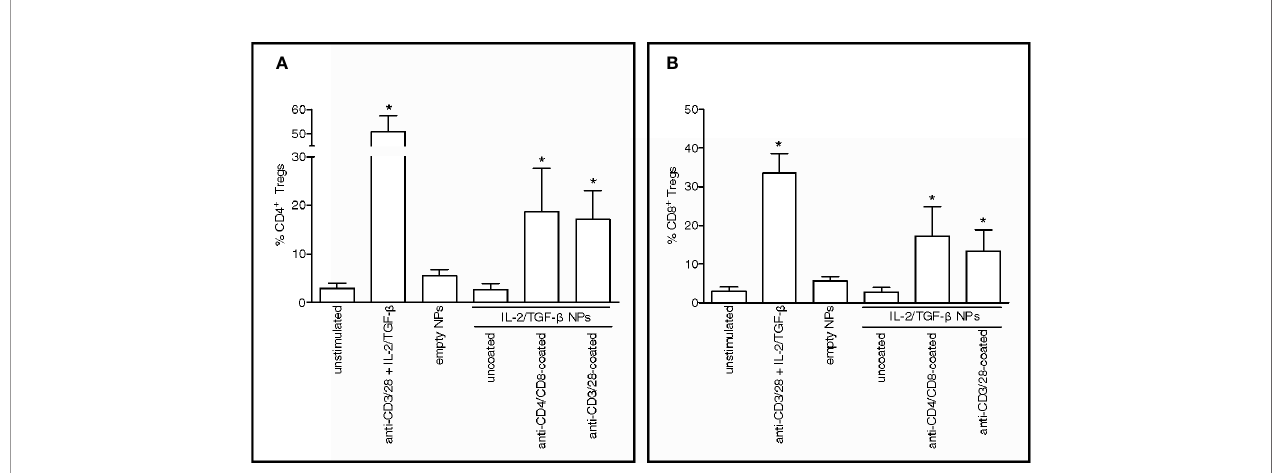
FIGURE 1 | Nanoparticles (NPs) loaded with tolerogenic cytokines and targeted to human T cells induce CD4 + and CD8 + Tregs in vitro . PBMCs from healthy volunteers (n = 5) were cultured for 5 days in the presence of 100 µg/ml NPs loaded with IL-2 and TGF- b that had been either left uncoated or decorated with antibodies to T cells (anti-CD4/CD8 or anti-CD3/28). Cultures with medium only and either no NPs (unstimulated) or NPs kept unloaded (empty) served as negative controls; cultures with anti-CD3/28 beads at a ratio of 0.2 beads/cell in the presence of soluble IL-2 and TGF- b served as positive control. Results show increased numbers of CD4 + CD25 hi CD127 - FoxP3 + (A) and CD8 + FoxP3 + T cells (B) in the presence of NPs decorated with anti-CD4/CD8 Ab or anti-CD3/CD28 Ab. *P < 0.05 by the Student ’ s t test in the comparison with unstimulated